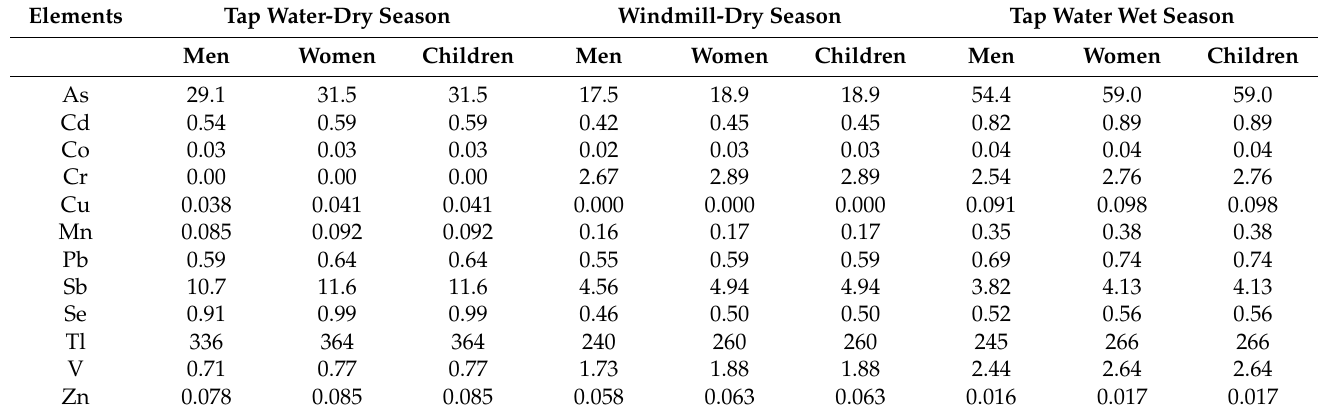
Table 6. Hazard quotient (HQ) values of trace metals through drinking water.